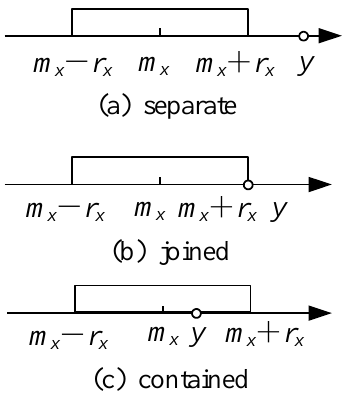
Figure 2. Distance relation between interval data and exact